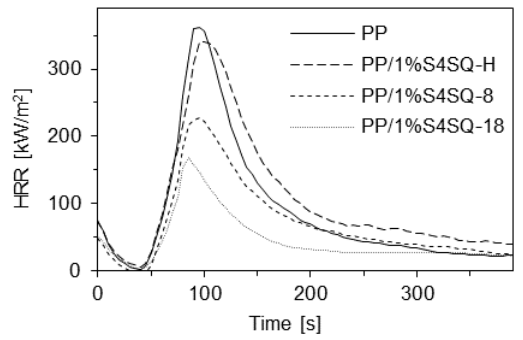
Figure 6. Dynamic curves of HRR versus time for neat PP and PP/S4SQ composites.